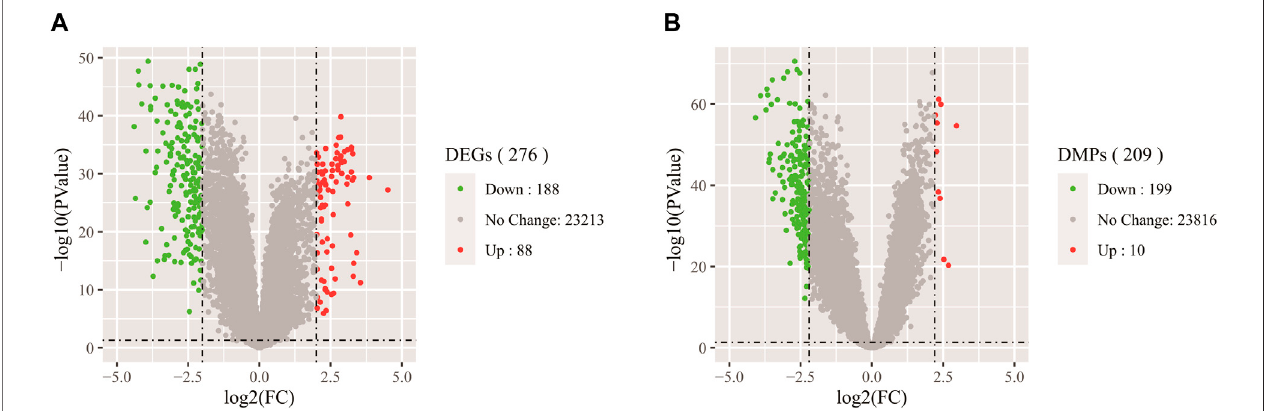
FIGURE 3 | (A) Volcano map of DEGs in gene expression data. (B) Volcano map of DMPs in DNA methylation data.